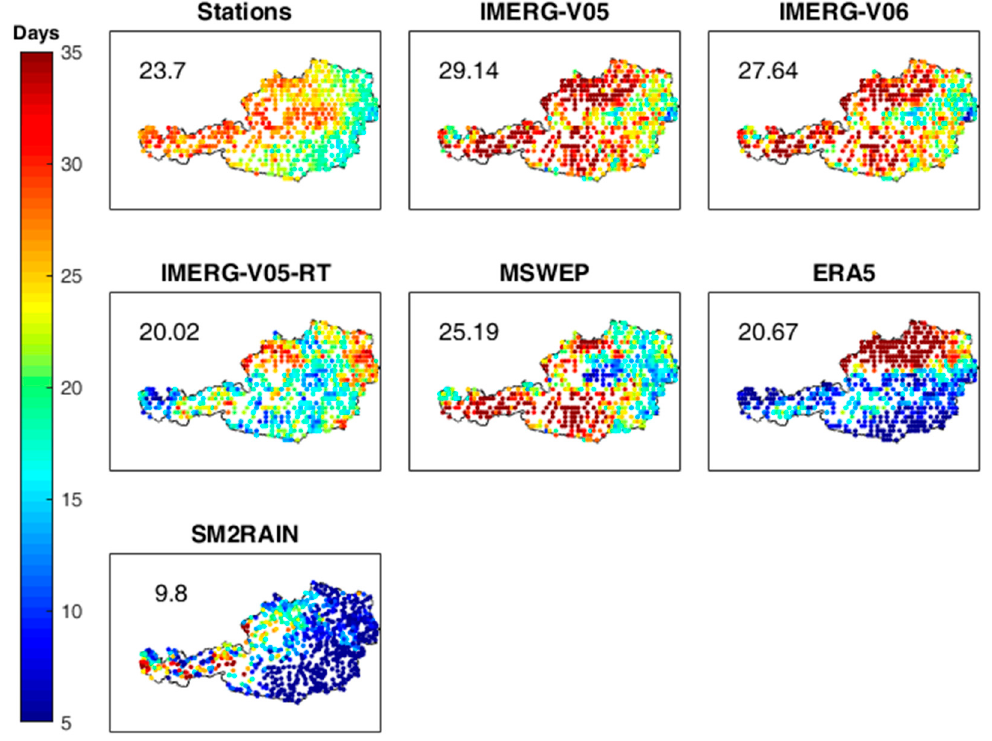
Figure 8. Distribution of daily R90th percentile of precipitation.